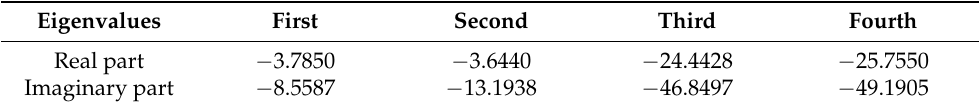
Table 2. The approximate eigenvalue solutions to the system matrix of the HIIRS-equipped vehicle.